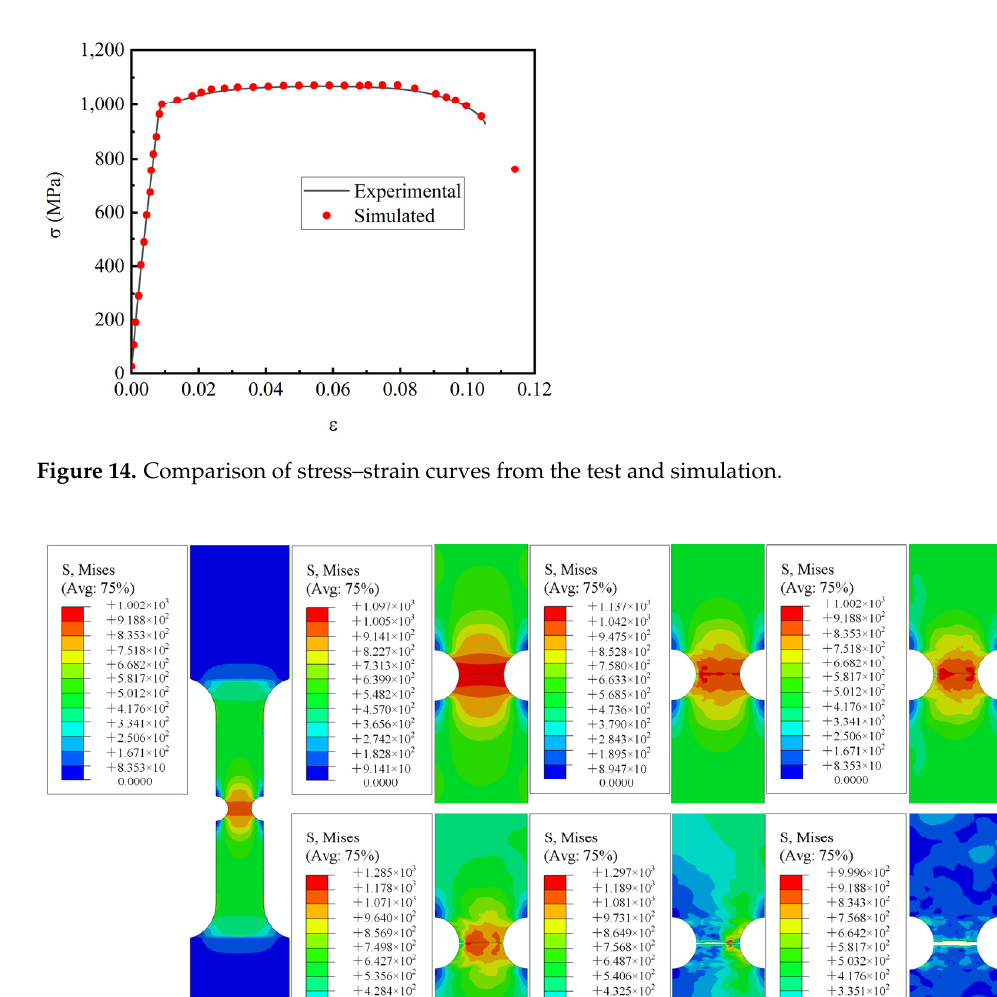
Figure 16. Notch specimen 2 (R = 5 mm).